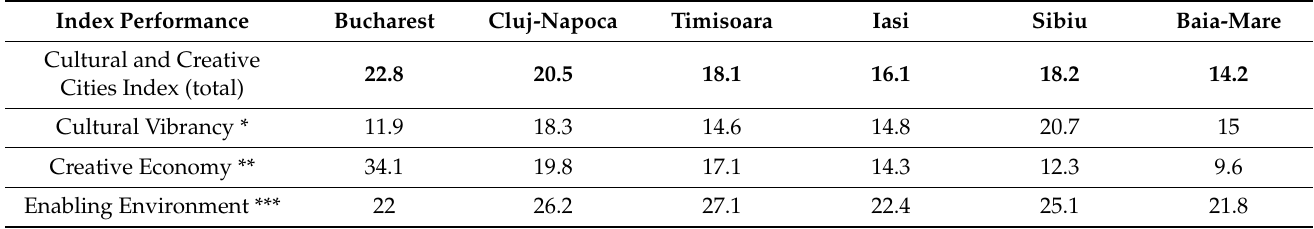
Table 3. Performance indices of cultural and creative industries in cities in